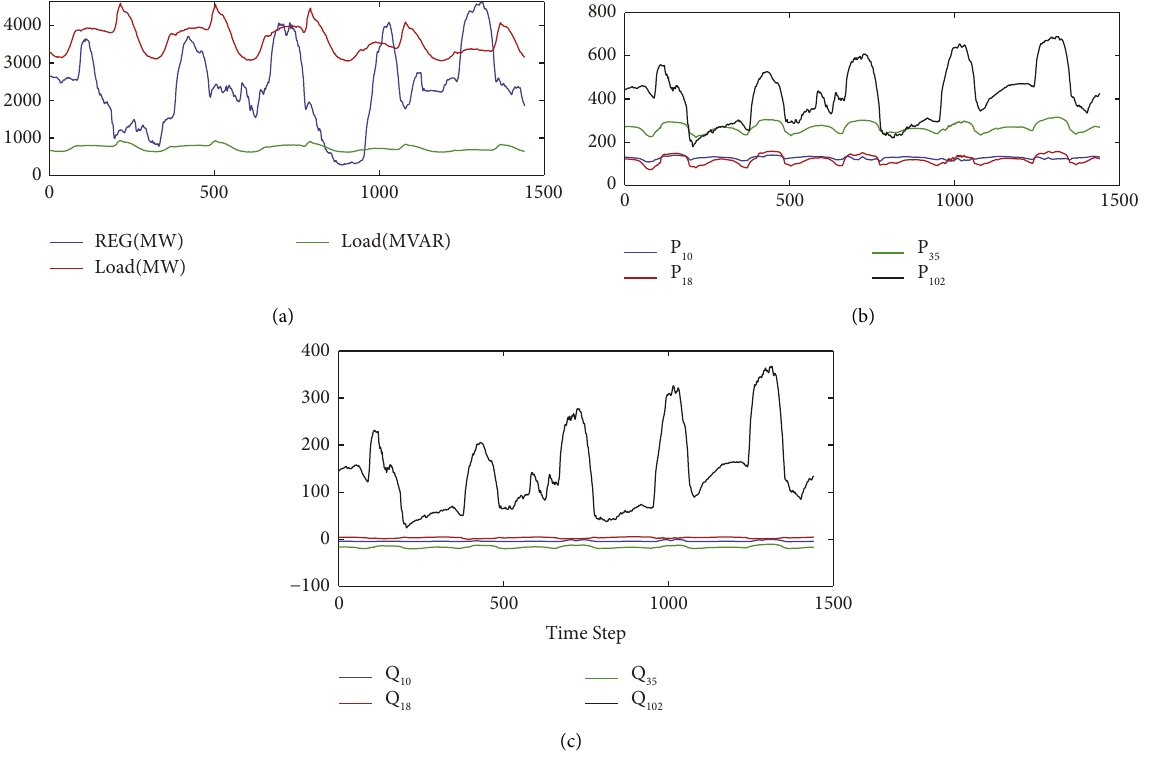
Figure 6: Time series profile of (a) DER generation output (MW) and load demand (MW/MVAR), (b) tie-lines’s active power flow (MW), and (c) tie-lines’s reactive power flow (MVAR).